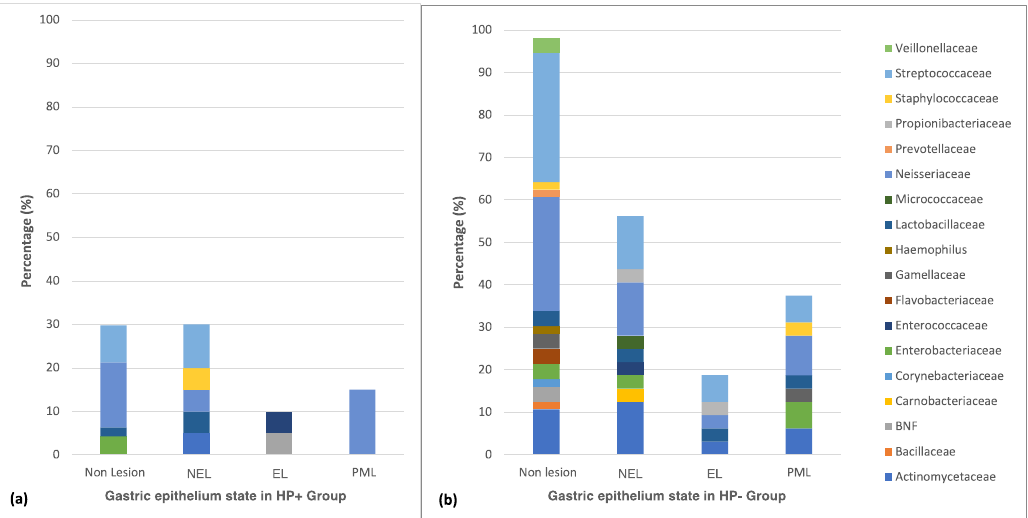
Figure 3. Cultivable gastric microbiota from the gastric epithelium. Distribution of cultivable bacteria present in the different states of the gastric epithelium, according to the HP+ group ( a ) and the HP- group ( b ). (NEL = Non-erosive lesion, EL = Erosive lesion, PML = Premalignant or Malignant lesion (atrophy or metaplasia). BNF: Gram-negative non-fermenting bacilli). BNF: Gram-negative non-fermenting bacilli.